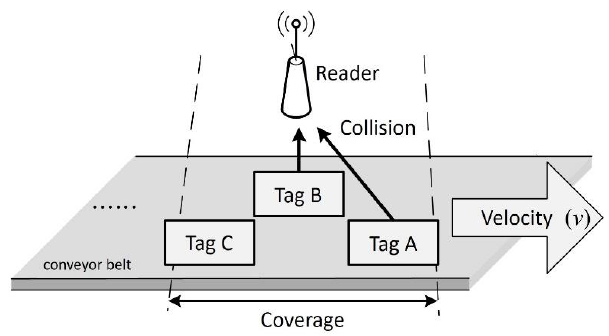
Figure 3. Dynamic RFID system.